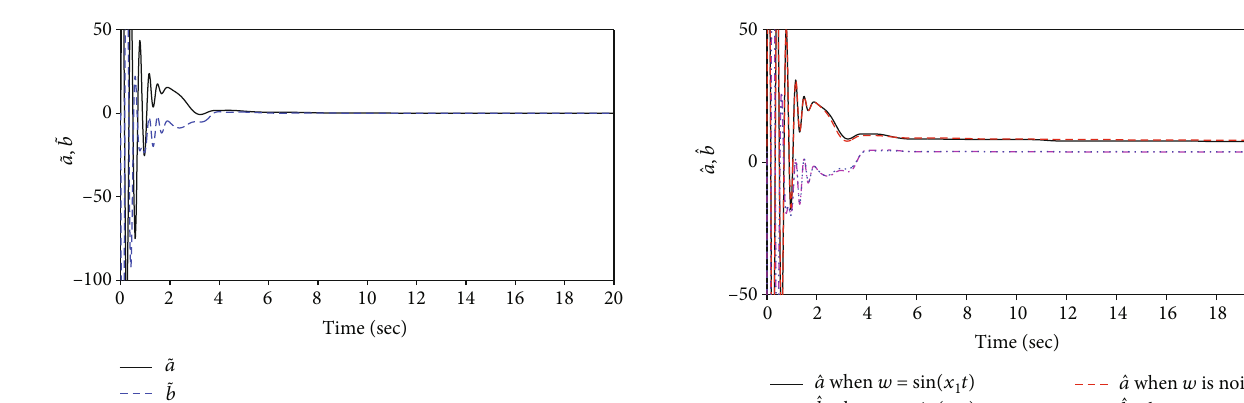
Figure 4: Time response of the parameter estimation errors.